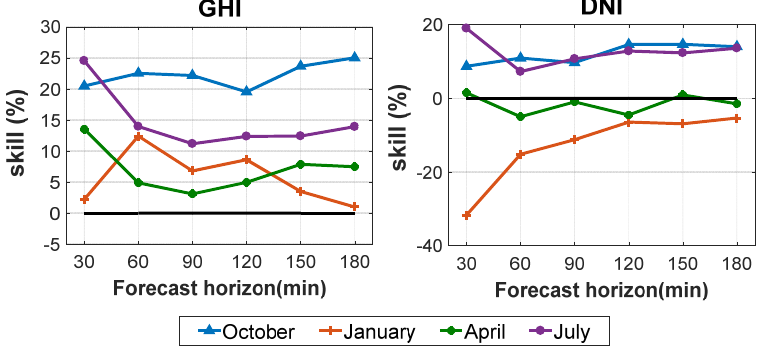
Figure 7. The skill values for GHI ( left ) and DNI ( right ) of various forecast horizons in four typical months (October 2018; January, April, and July 2019).